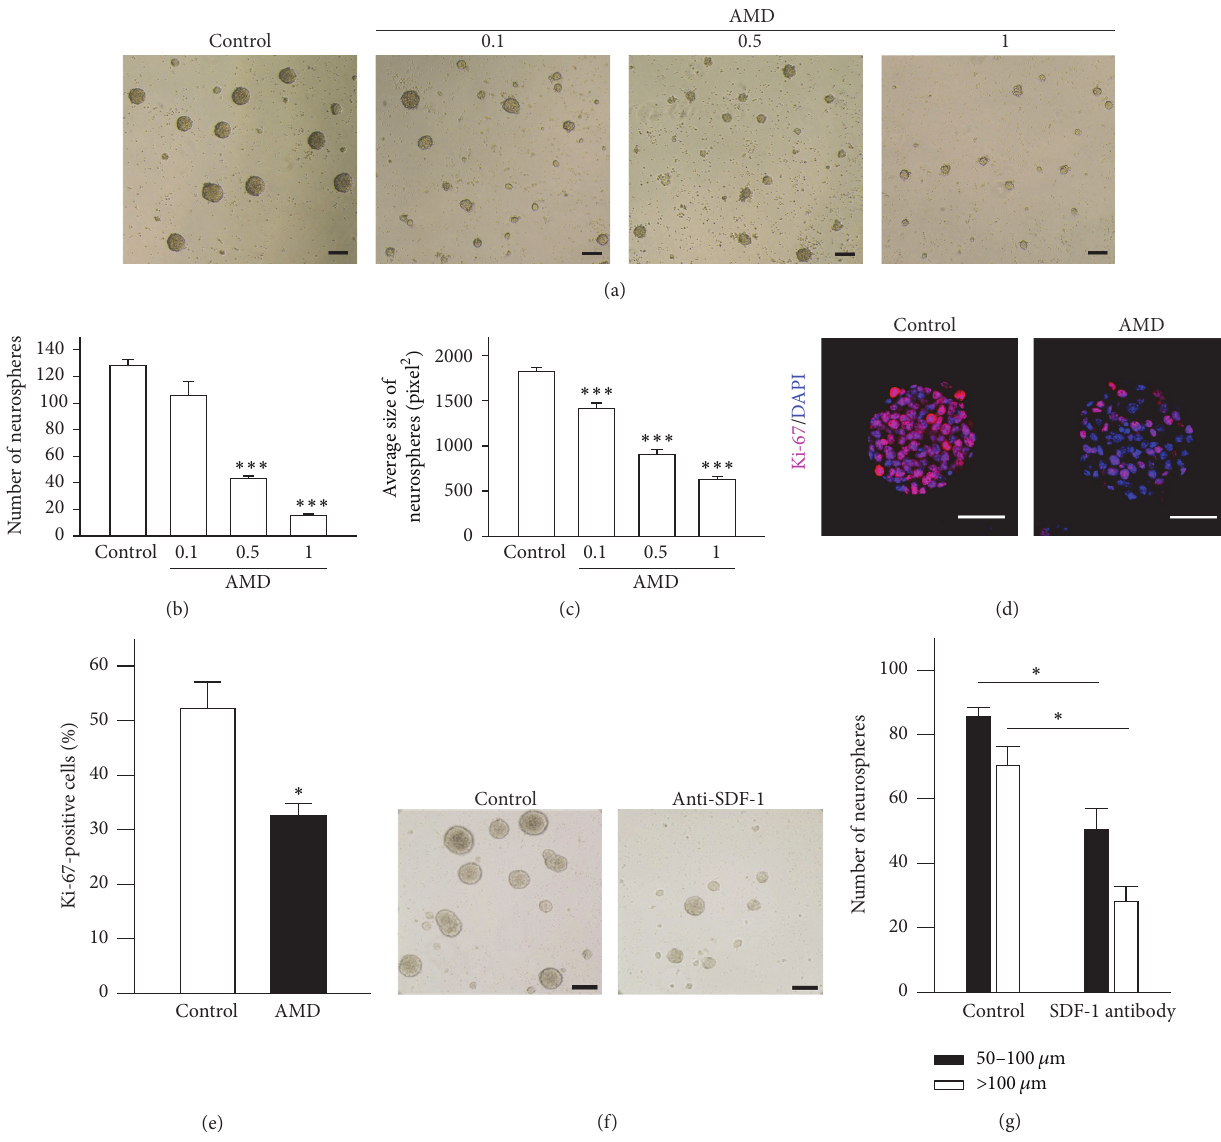
Figure 2: Blocking of SDF-1/CXCR4 pathway impaired growth factor-induced neurospheres formation in vitro. (a) Representative images of 6DIV neurospheres in varying concentration of AMD (0.1, 0.5, and 1.0 𝜇 g/mL). Scale bar, 100 𝜇 m. (b) (c) CXCR4 specific antagonist, AMD, significantly decreased the number or size of primary neurospheres formation in a dose-dependent manner. Data represent the mean ± SEM, 𝑛 = 3 , ∗∗∗ 𝑝 < 0.001 . (d) Representative staining images of 6DIV neurospheres. Equal sizes of neurospheres incubated with PBS (control, left panel) or 1.0 𝜇 g/mL AMD (AMD, right panel) were stained with cell proliferative marker, Ki-67, to evaluate the self-renewal ability of cells. Scale bar, 50 𝜇 m. (e) Quantification of the percentage of Ki-67 + cells in a single neurosphere. Data represent the mean ± SEM, 𝑛 = 3 , ∗ 𝑝 < 0.05 . (f) Representative pictures of neurospheres after 6 days of SDF-1 antibody application. Scale bar, 100 𝜇 m. (g) Quantification of neurospheres with medium size ( > 50 𝜇 m) or large size ( > 100 𝜇 m) after SDF-1 antibody neutralization. Data represent the mean ± SEM, 𝑛 = 3 , ∗ 𝑝 < 0.05 , Student’s 𝑡